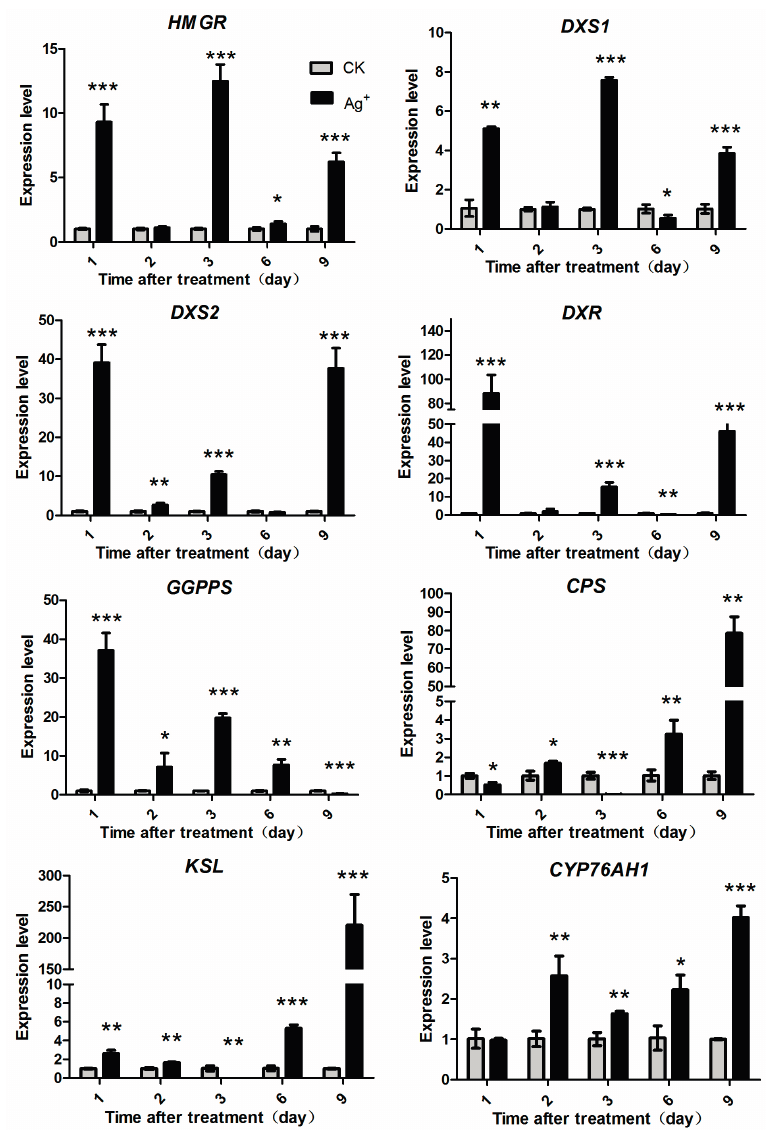
Figure 7. Effects of Ag + on the expression level of eight key enzyme genes of tanshinones biosynthesis pathway (MEP pathway and MVA pathway) in S. miltiorrhiza hairy roots. The vertical bars show the SD values ( n = 3). The asterisks indicate statistically significant differences at p < 0.05 ( * , 0.01 < p < 0.05; ** , 0.001 < p < 0.01; *** , p < 0.001.) between the content in the elicitor treated cultures and that in the corresponding